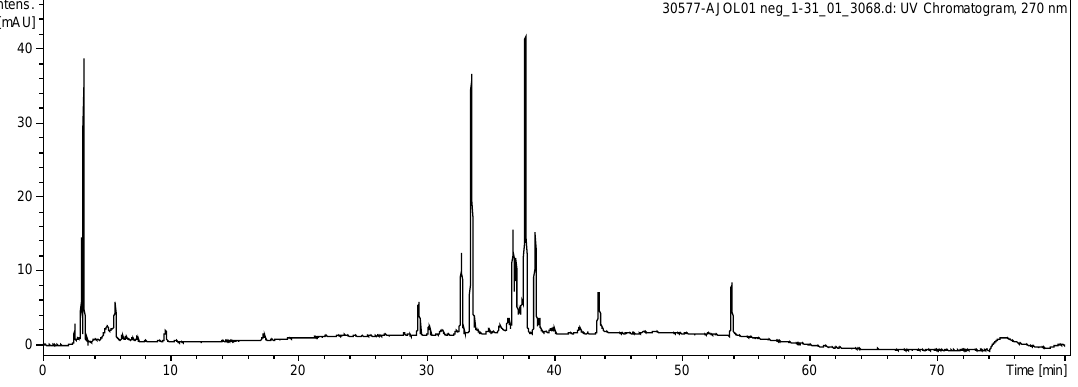
Figure 5. Formalin test induced by subplantar administration of 2.5% formalin in mice treated orally with 0.9% NaCl, indomethacin 10 mg/kg, EHPC 250 and 500 mg/kg. * p < 0.05; *** p < 0.01; **** p < 0.001 vs. NaCl; # p < 0.05; ## p < 0.005 vs Indomethacin (ANOVA; Tukey).